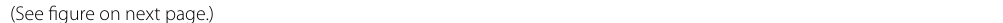
(See figure on next Fig. 2 Microstructure of initial olivine grains ( a , b ), olivine grains after the experiment (grain A: c , d ; grain B: e , f ), and an FIB section from grain B ( g , h ). a , b Typical olivine grains used as the starting materials. These grains had a smooth surface with smaller olivine particles (~1 μm) attached to them. c , d Grain A was partially covered with precipitation features. Conical etch pits were also detected. e , f Grain B was entirely covered with polyhedral etch pits. Irregularly shaped carbonaceous materials (1–10 μm, white particles) were attached to the surface. g , h An FIB section obtained from grain B (red broken area)